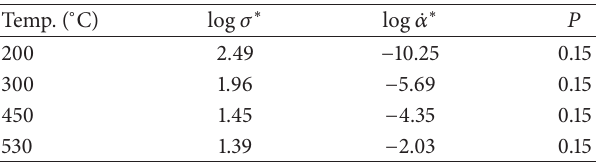
Figure 4: The effect of temperature on the flow behavior of 8090 Al-Li with the average grain size of 50 𝜇 m. Table2:Theconstitutiveparametersfor ̇𝛼 elementdeterminedfrom the load relaxation test results of 8090 Al–Li with the grain size of 50 𝜇 m.